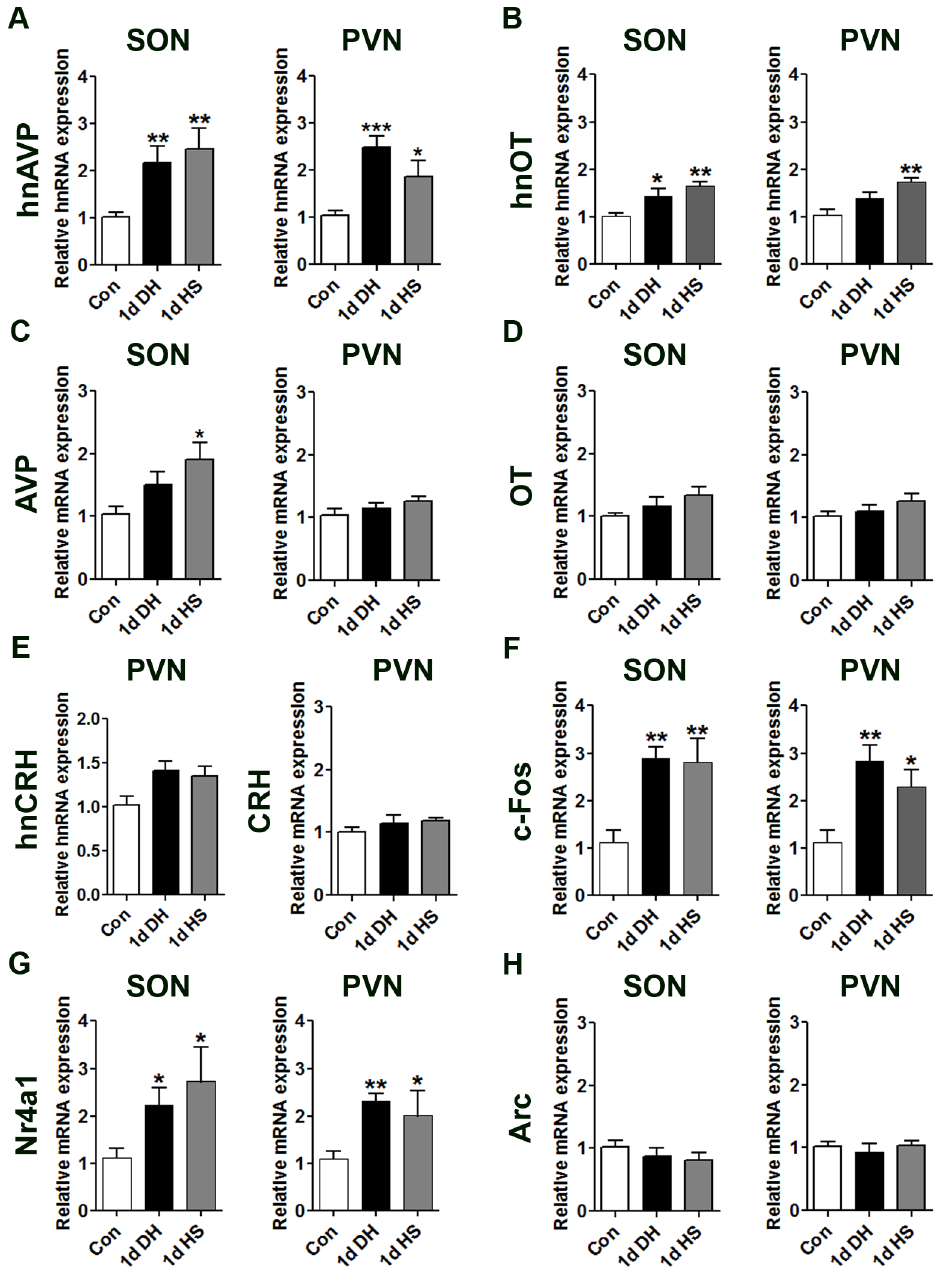
Figure 5. The effects of 1 d DH and 1 d HS exposure on gene expression in rat SON and PVN. Relative mRNA expression of hnAVP, hnOT, AVP, OT, hnCRH, CRH, c-Fos, Nr4a1 and Arc was investigated by qPCR in the SON and PVN of control, 1 d DH and 1 d HS rats. Values are means + SEM of n=5–6 animals per group. *p , 0.05, **p , 0.01, ***p , 0.001. 1 d DH, 1 day dehydrated; 1 d HS, 1 day hypertonic saline.